Question: Write a descriptive caption for this figure.
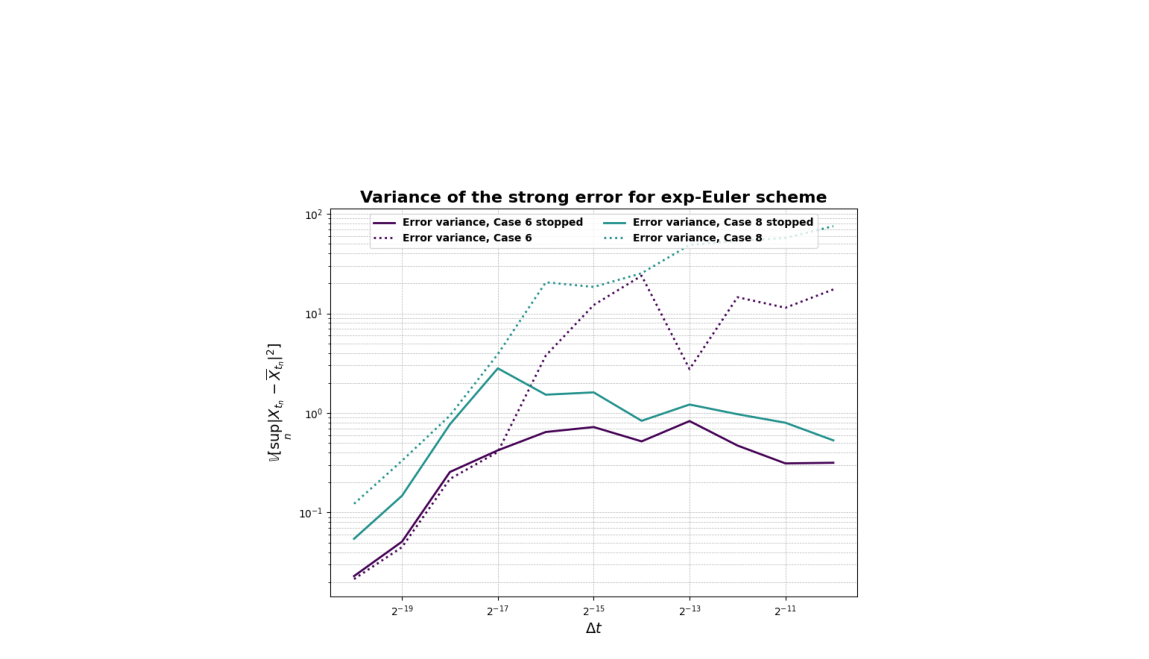
Answer: Variance of the approximation error (stopped and non-stopped) for the Exp-EM scheme applied in Cases 6 and 8 (in log-log scale).